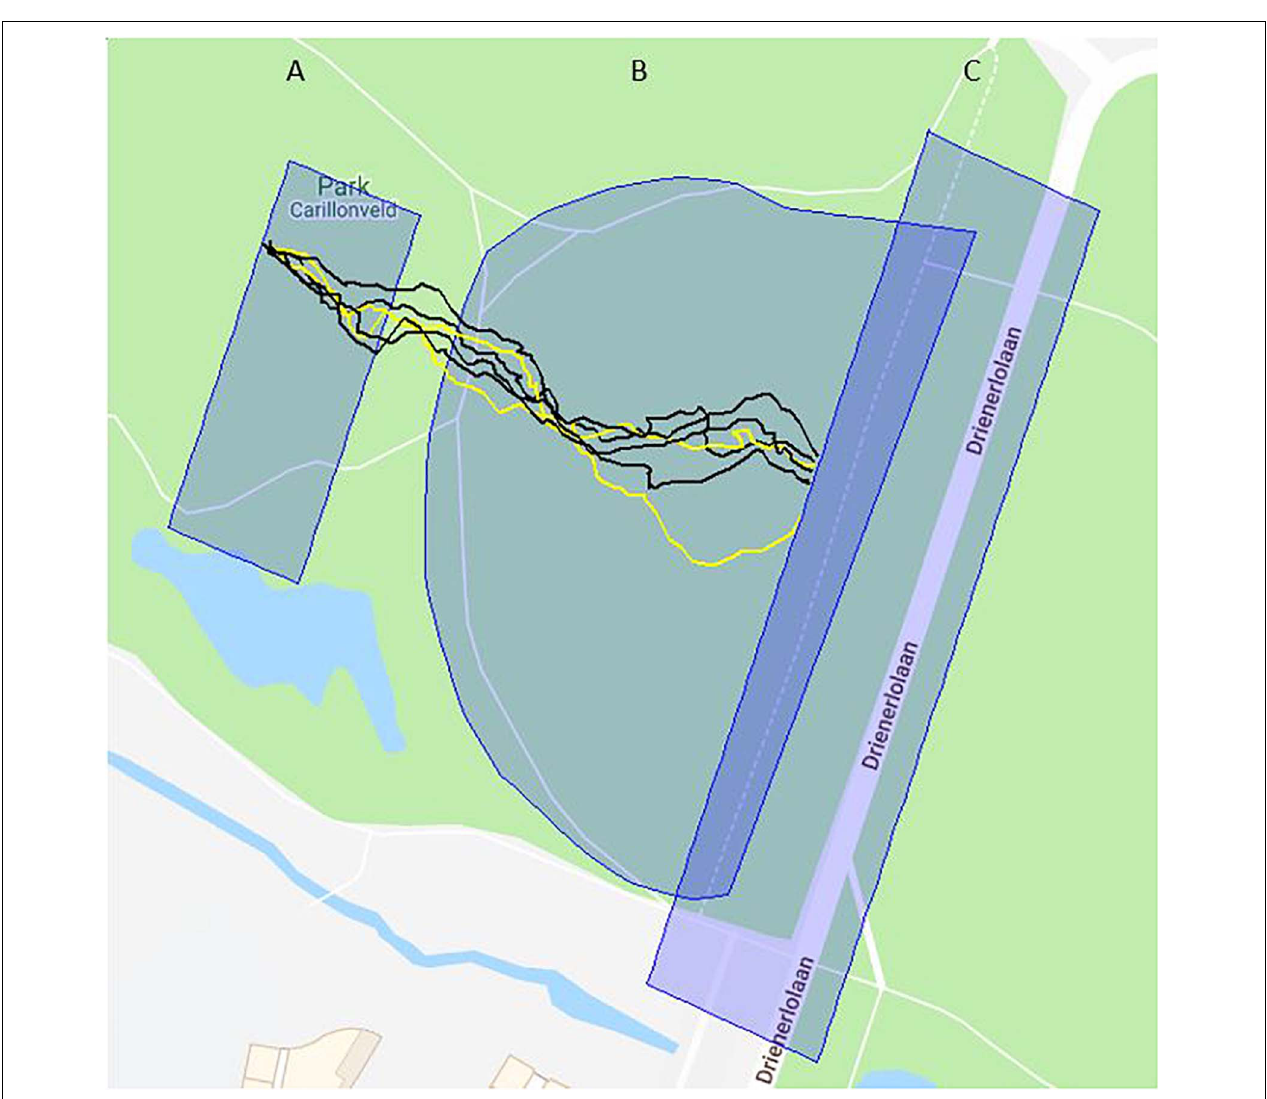
FIGURE 1 | Experiment area with participant tracks and GPS polygons. The tracks of six team members in Experiment 2 are plotted in black (illegal card) and yellow (legal card). They started in polygon (A) , crossed the semi-circular bicycle path into the area where they would be visible to the guards (polygon B ), and ended before the finish (polygon C